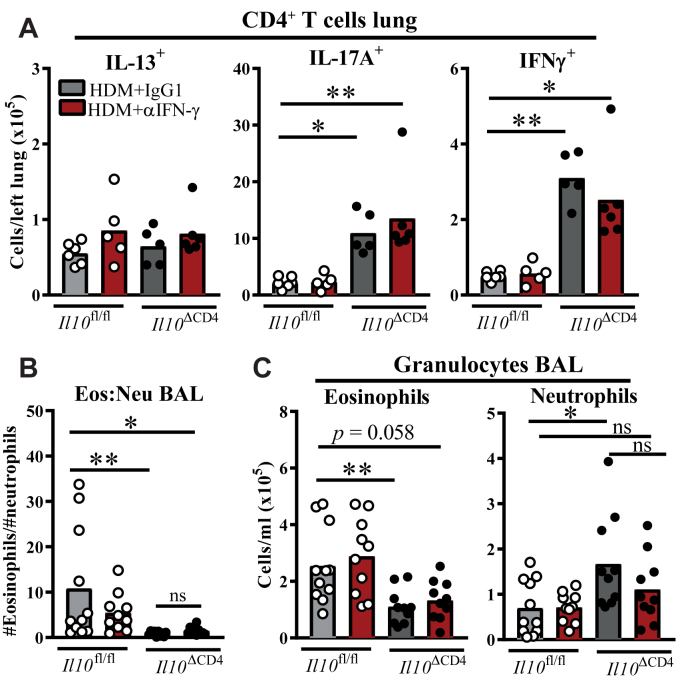
Therapeutic IFN-γ blockade partially corrects the inflammatory phenotype in Il10ΔCD4 mice. Flow cytometric data are shown. A, Numbers of CD4+ T cells with the indicated cytokine phenotype in lung tissue. B, Ratio of eosinophil (Eos) to neutrophil (Neu) numbers in BAL fluid. C, Absolute numbers of eosinophils and neutrophils in BAL fluid. Data in Fig E7, A, are representative of 2 experiments (n = 5-6 per group) showing comparable trends. Data in Fig E7, B and C, are pooled from 2 experiments (n = 10-11 per group). Data shown are medians and individual replicates. *P < .05 and **P < .01. ns, Nonsignificant.